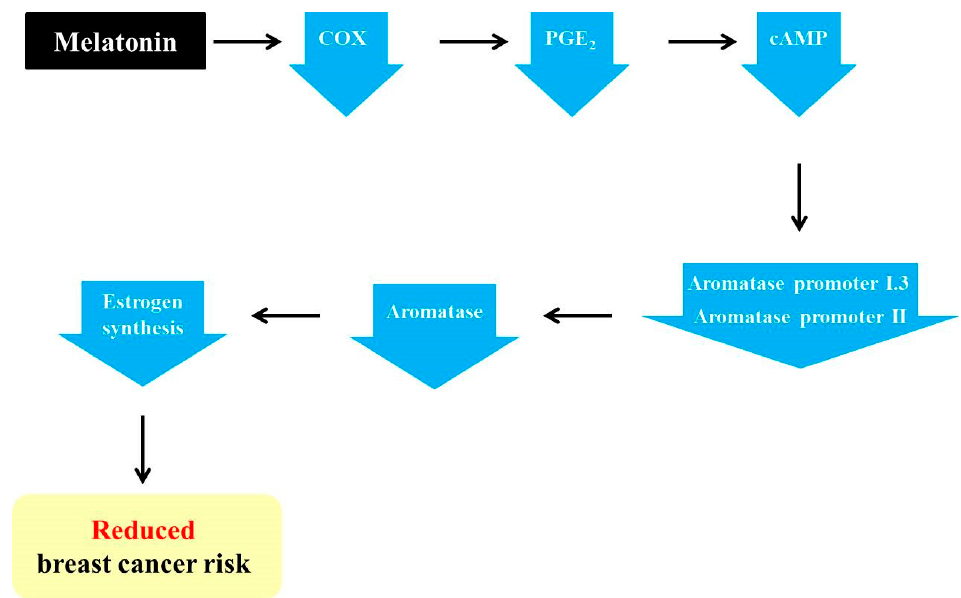
Figure 1. Melatonin-induced reduction in the risk of breast cancer via its regulation of aromatase promoters and related genes. Melatonin downregulates the levels of cyclooxygenase (COX) enzymes and leads to a reduction in prostaglandin E2 (PGE 2 ). In turn, cAMP is also decreased, resulting in a decline in aromatase promoters I.3 and II and, ultimately, aromatase. Then, the decreased aromatase level impedes estrogen synthesis, thereby reducing the risk of breast cancer.